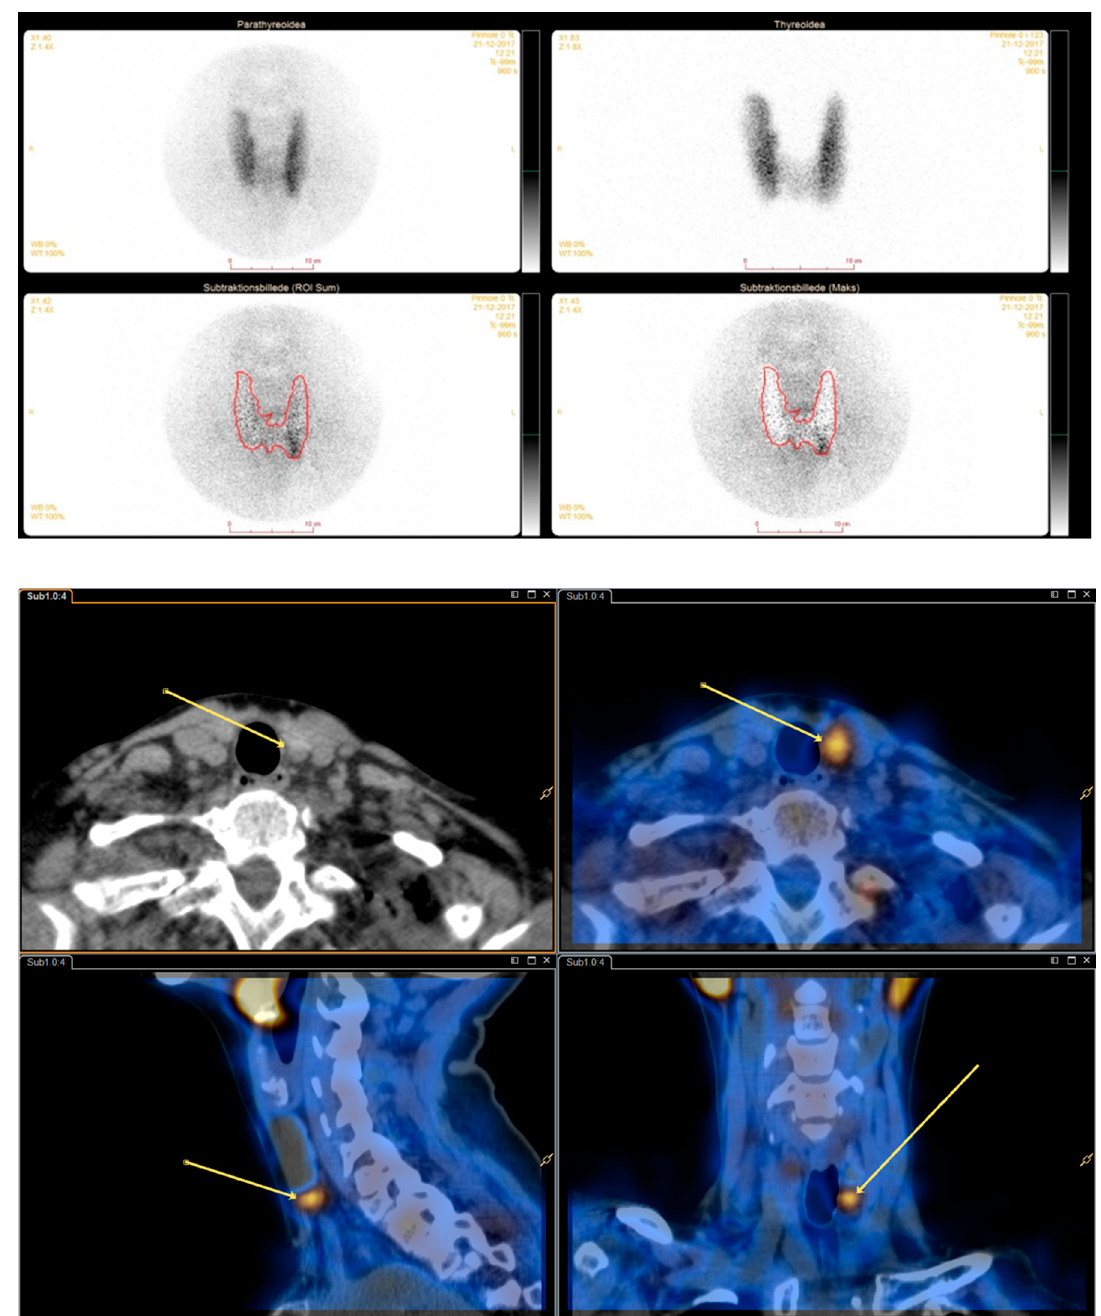
Figure 1. Dual isotope planar pinhole subtraction scintigraphy and dual isotope subtraction single-photon emission computed tomography/computed tomography (SPECT/CT) images. ( top image ) Upper left: Tc-99m-sestamibi pinhole. Upper right: I-123 pinhole. Middle left and right: Varying degrees of subtraction. ( bottom image ) Dual isotope subtraction SPECT/CT with and without fusion.